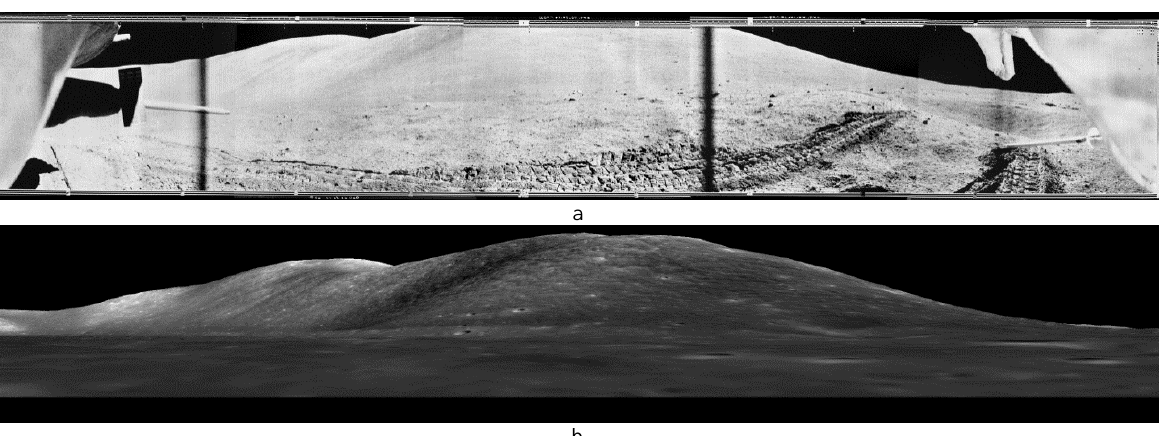
Figure 5. a – original Lunokhod-2 panorama #434; b – synthetically modelled panorama #434 based on determined exterior